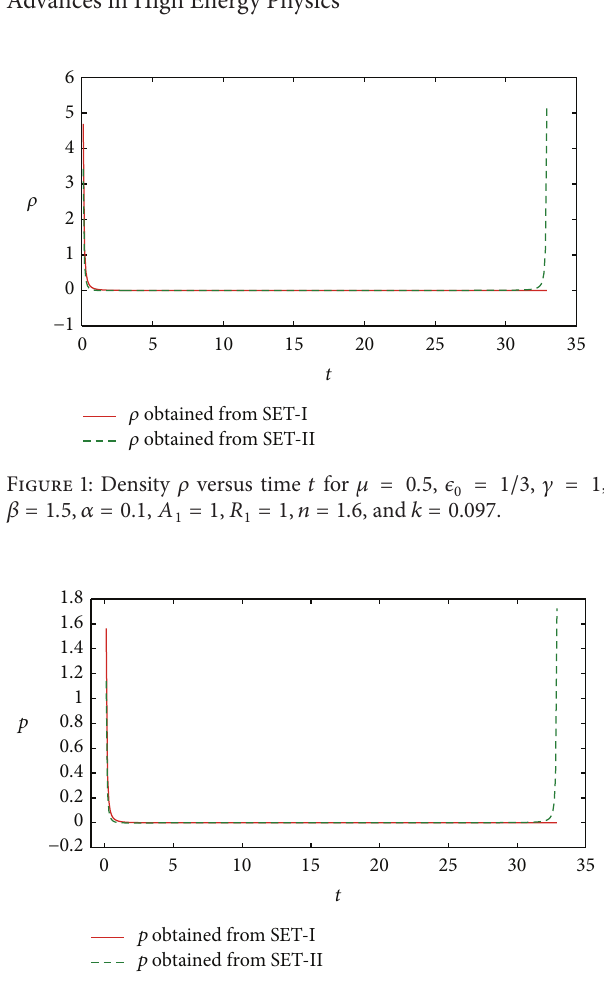
Figure 2: Proper pressure 𝑝 versus time 𝑡 for 𝜇 = 0 . 5, 𝜖 0 = 1 / 3, 𝛾 = 1, 𝛽 = 1 . 5, 𝛼 = 0 . 1, 𝐴